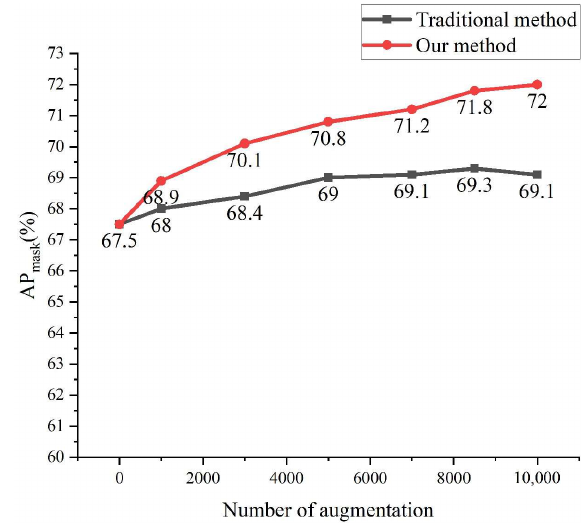
Figure 16. Comparison of AP mask .